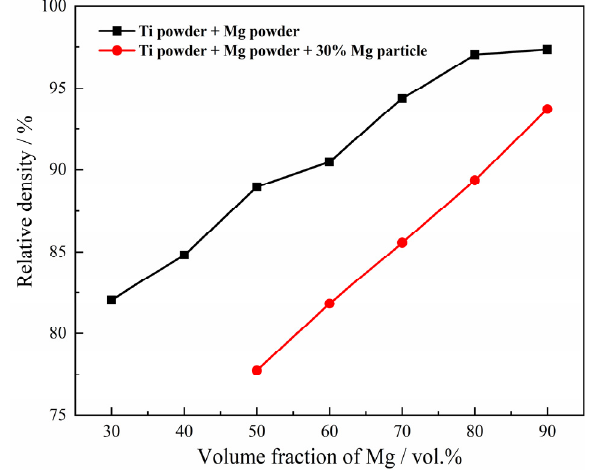
Figure 4. Relationship between content of magnesium and relative density of the green compact.